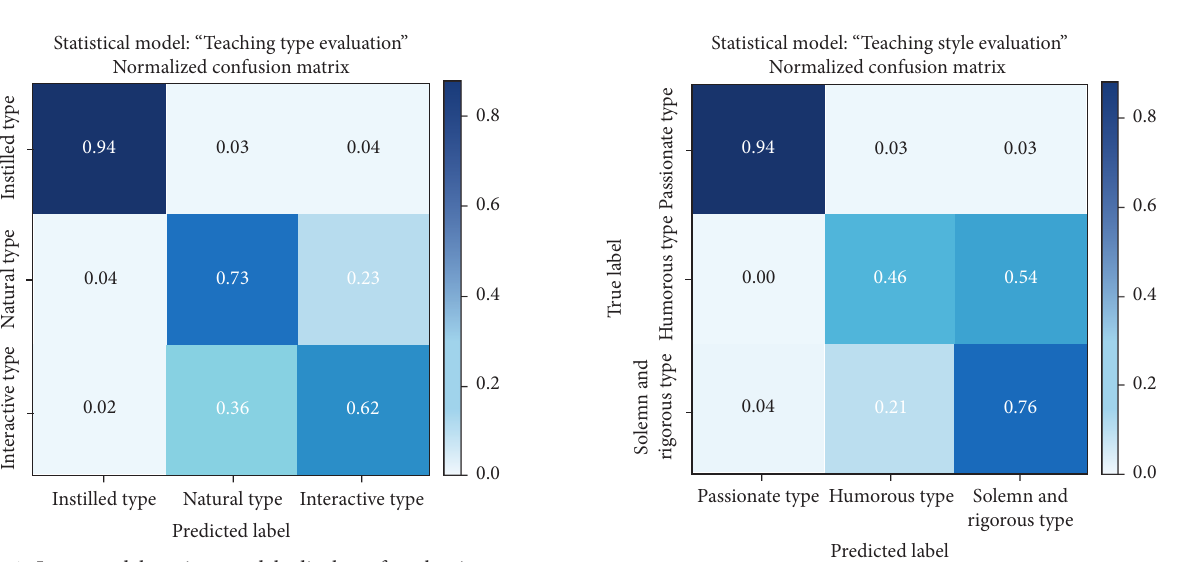
Figure 5: Integrated learning model: the evaluation performance display of the “evaluation of teaching style” indicator.